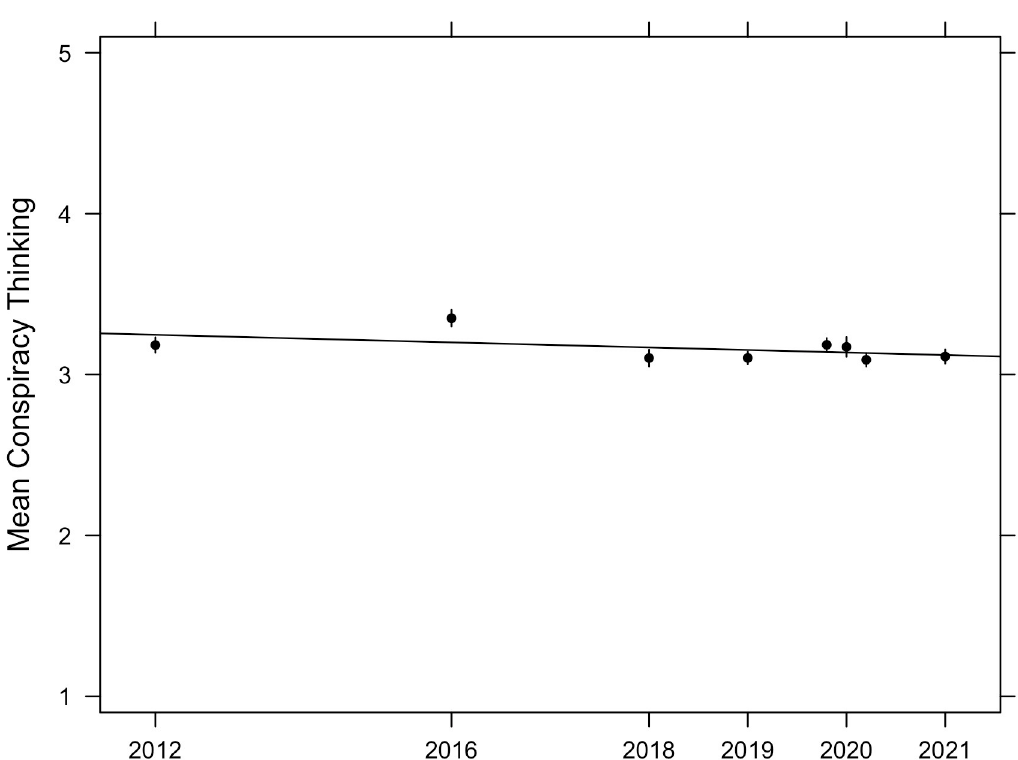
Fig 4. Average level of conspiracy thinking. Conspiracy thinking is measured with the ACTS (range 1–5), over time. Vertical lines are 95% confidence intervals, horizontal line is OLS